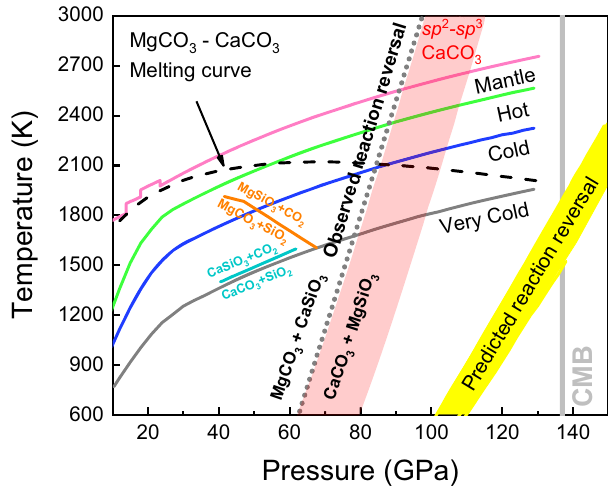
Fig. 2 Phase diagram for the relative stability of the MgCO 3 + CaSiO 3 assemblage versus CaCO 3 + MgSiO 3 . The boundary sketched as a black dashed line with gray shadow as uncertainty inferred is based on experimental observations of carbonate – silicate exchange reactions CaC- to-MgC and MgC-to-CaC. Squares represent observations from this work starting with (Ca,Mg)CO 3 and (Mg,Fe)SiO 3 , looking for newly synthesized CaSiO 3 to indicate the CaC-to-MgC reaction takes place. Circle symbols represent observations from this work of experiments starting with (Mg,Fe) CO 3 + CaSiO 3 , looking for identi fi cation of newly synthesized MgSiO 3 to indicate the MgC-to-CaC reaction takes place. Open symbols indicate nonreaction and fi lled for con fi rmed reaction, and blue and red colors correspond to the inferred stable phase assemblage based on reaction products. Triangles indicate the P – T conditions for CaC-to-MgC taking place reported by Seto et al. 25 , and blue-shaded region indicates approximate conditions of four experiments conducted by Biellmann et al. 24 using indirect methods for pressure and temperature calibration, which all produced the run products MgCO 3 + CaSiO 3 . The error bars indicate uncertainties of pressure and temperature measurements (see “ Methods ” for details). The boundaries proposed by previous theoretical predictions are illustrated by yellow-shaded region 28 – 30 .